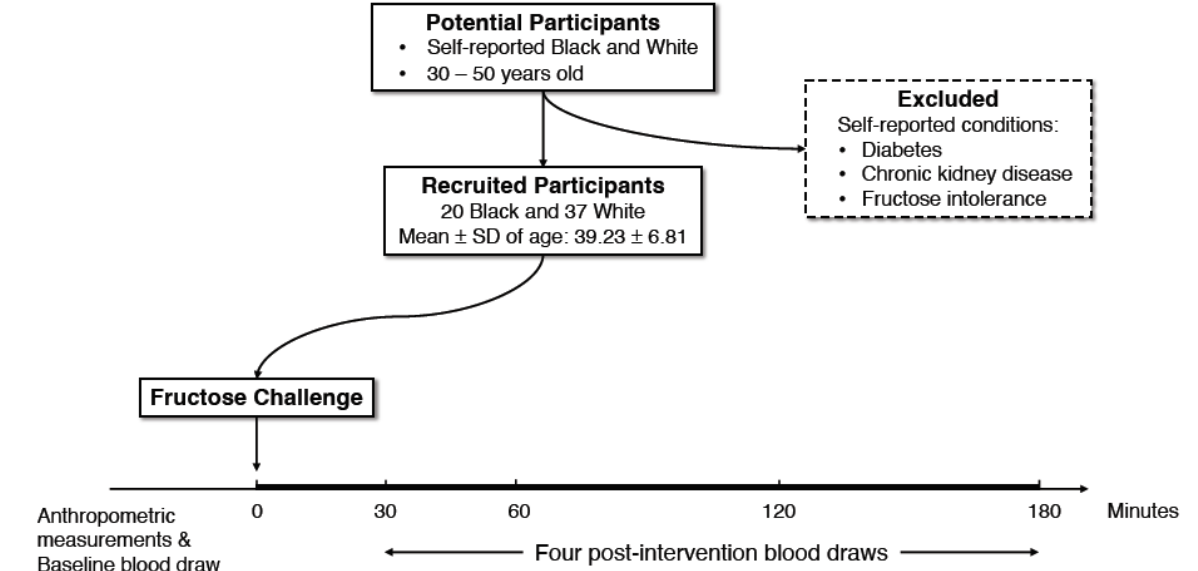
Figure 1. Study design. The Fructose Challenge Study (FCS) is a pilot study with a dietary intervention designed to investigate the acute effects of a sugar-sweetened beverage (SSB) containing 80% fructose on serum urate concentrations in adults 30–50 years of age who self-identified as Black or White.